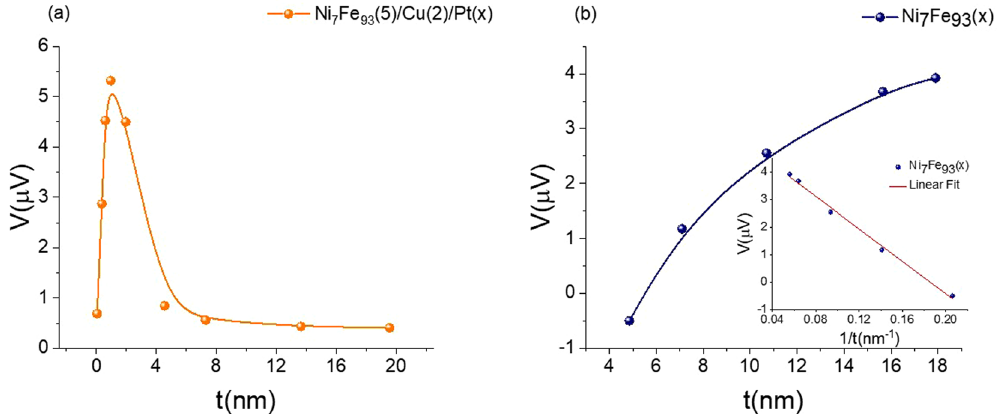
Figure 4. ( a ) Thermal voltage measured for Ni 7 Fe 93 (5)/Cu(2)/Pt(x). Thickness dependence is similar to the case without Cu insertion, except for reduction in magnitude, owing to shorting due to Cu and change in the transparency for spin current with the insertion of the Cu layer. ( b ) Thermal voltage measured for Ni 7 Fe 93 (x) and the inset shows the thermal voltage dependence on inverse